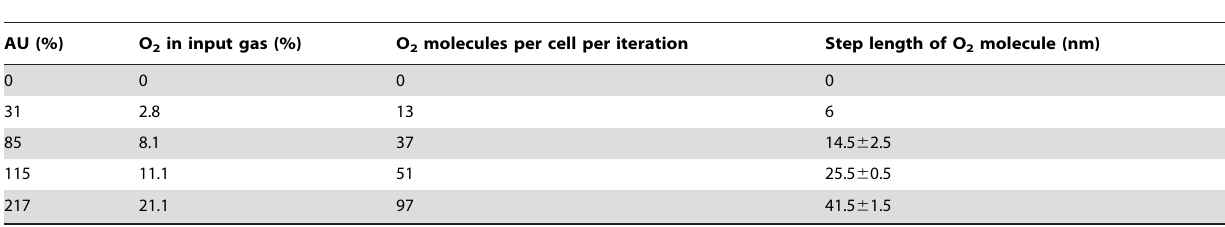
Table 4. Relative parameters for O 2 molecules.